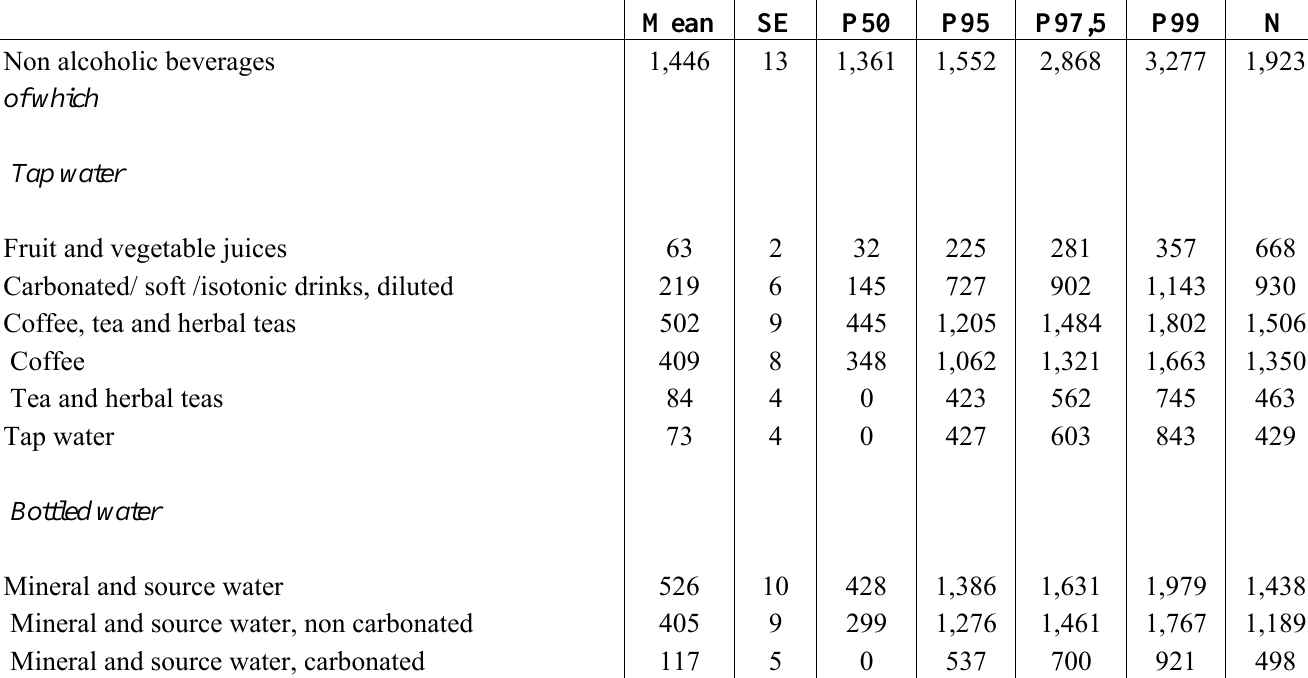
Table 1. Mean (SE, P50, P95, P97.5, P99) usual consumption of non-alcoholic beverages in Flanders (mL/day), all days, entire adult population (Food consumption survey,